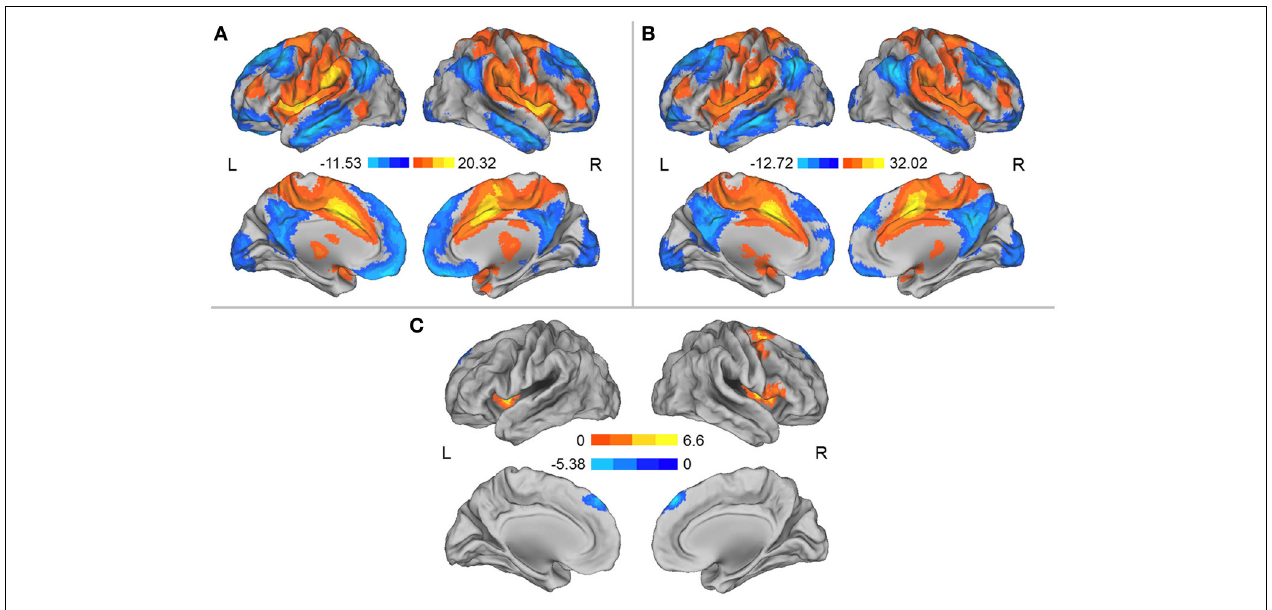
FIGURE 3 | (A) Regions exhibiting significant RSFCs with the MCC before HDT bed rest. (B) Regions exhibiting significant RSFCs with the MCC after HDT bed rest. (C) Regions exhibiting significant changes in positive and negative RSFCs with the MCC between the pre- and post-HDT bed rest